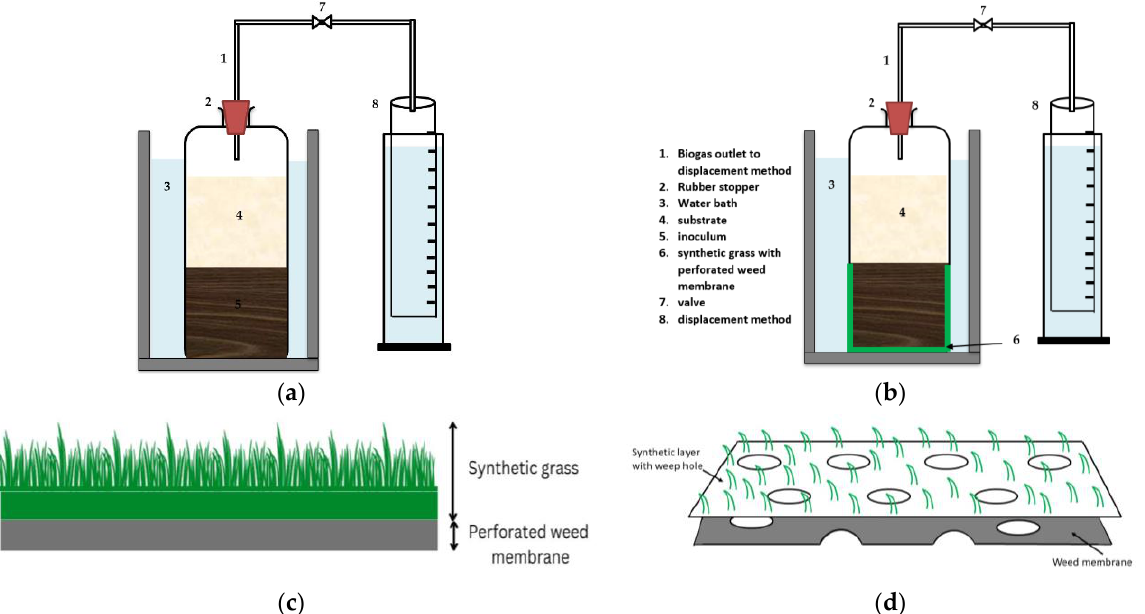
Figure 1. ( a ) Schematic diagram of BMP WoF; ( b ) schematic diagram of BMP WF; ( c ) cross-section of synthetic grass; ( d ) details of perforated weed membrane.